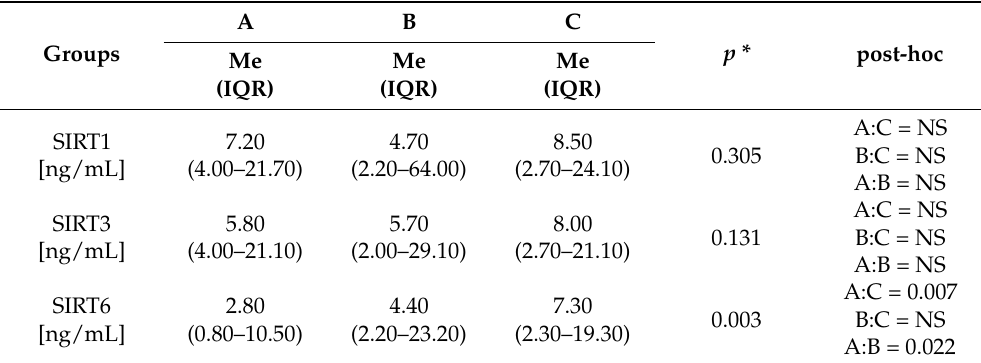
Table 3. Results for SIRT1, SIRT3 and SIRT6 in the plasma of HIV-infected men before ( A ) and after cART ( B ) and in the control group ( C ) with statistical